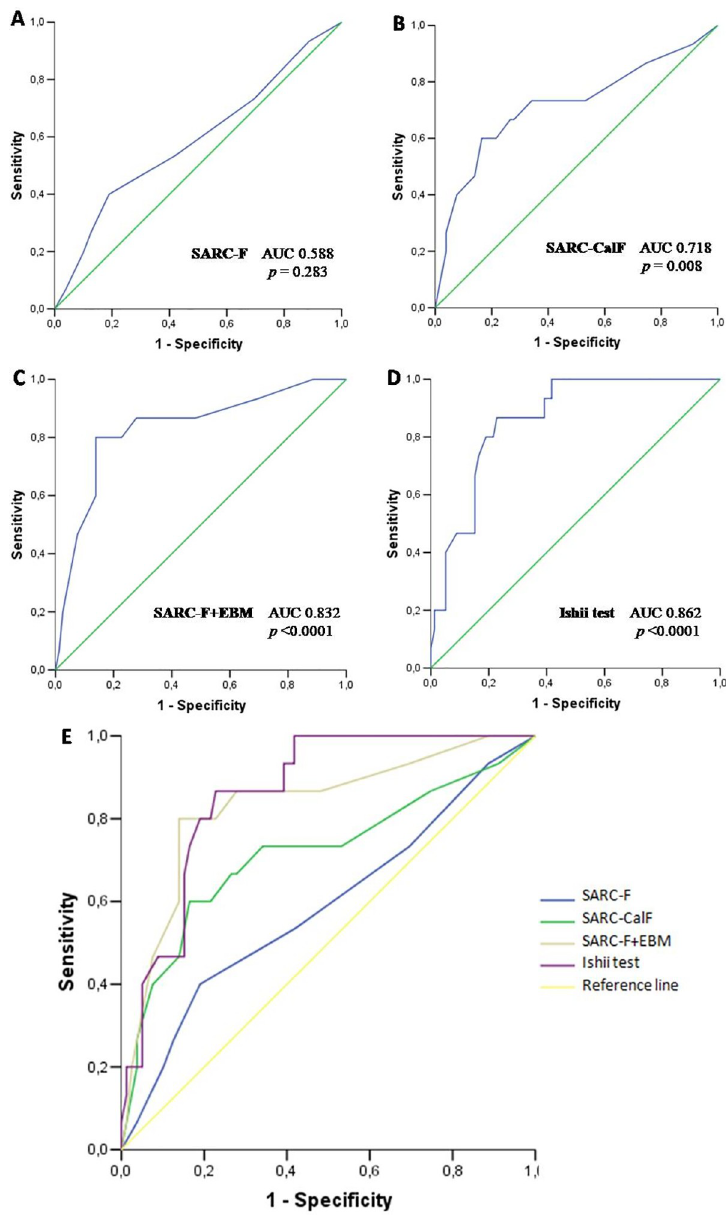
Fig 2. Receiver operating characteristic (ROC) curve analysis of four sarcopenia screening tests in relation to sarcopenia defined according to EWGSOP2 criteria: SARC-F (A), SARC-CalF (B), SARC-F + EBM (C), and Ishii screening test (D). Comparison of ROC curves between the SARC-F, SARC-CalF, SARC-F + EBM, and Ishii’s scores for the sarcopenia screening